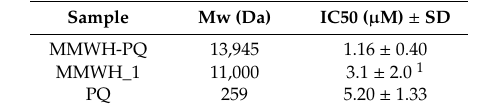
Table 3. In vitro P. falciparum growth inhibition activity assay of the heparin-PQ conjugate.